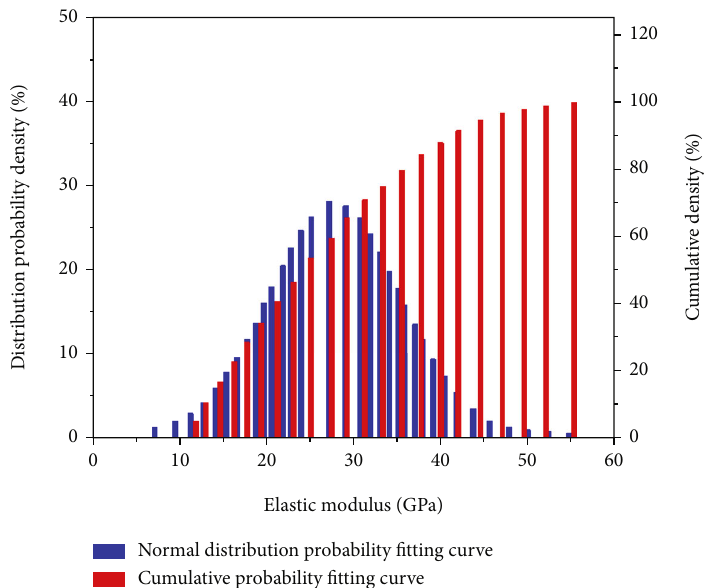
Figure 4: Probability distribution and fi tting curve of the elastic modulus.